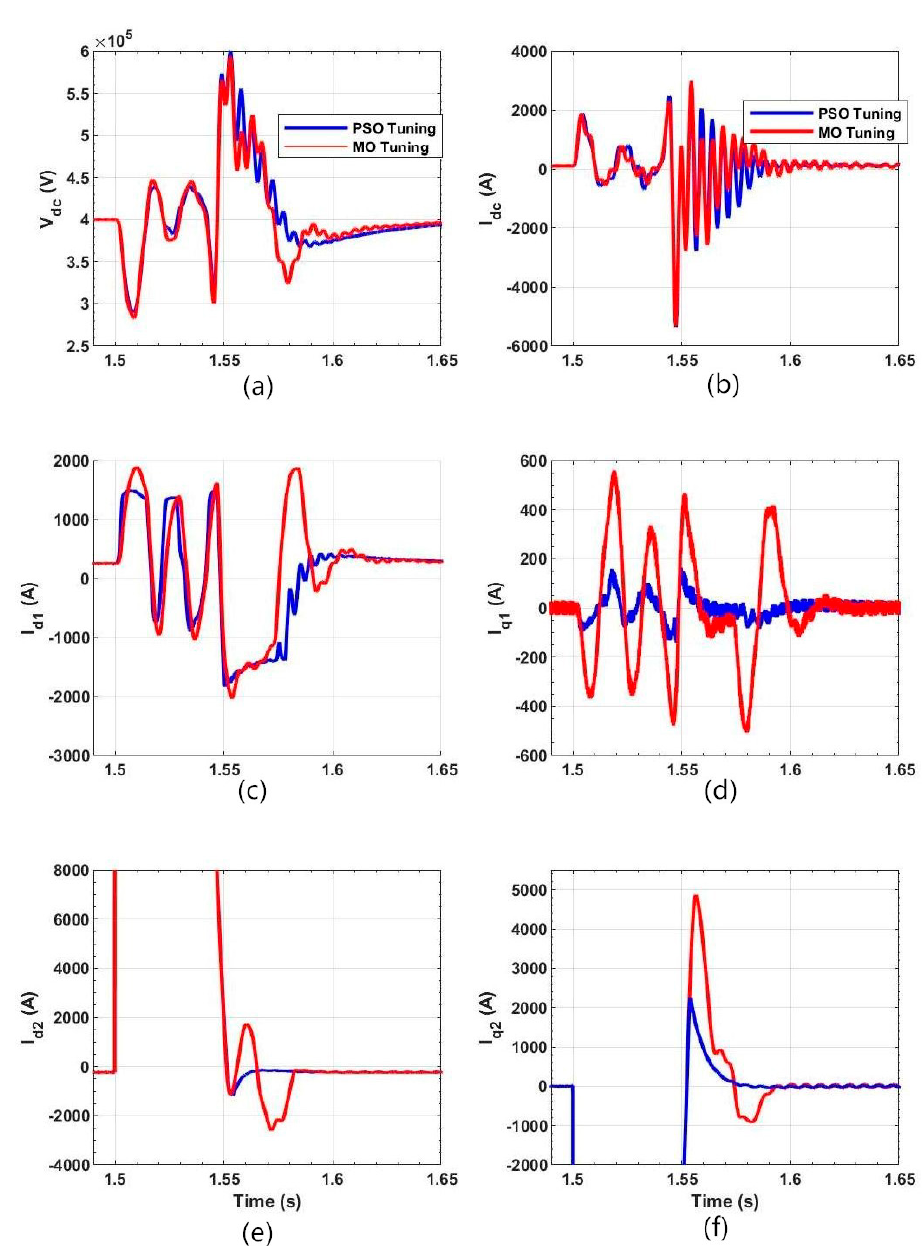
Figure 7. Comparison between PSO and MO tuning methods for two cycle LLLG fault at grid2. ( a ) DC link Voltage ( b ) DC link current ( c ) d axes current for conv-1 ( d ) q axes current for conv-1 ( e ) d axes current for conv-2 ( f ) q axes current for conv-2.